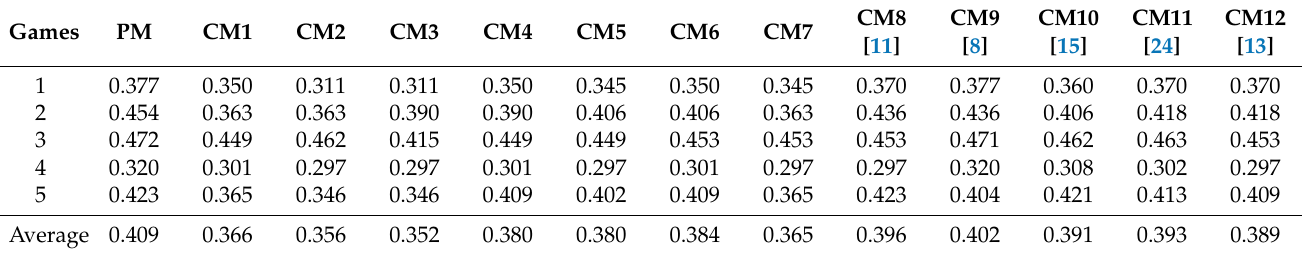
Table 3. Specificity of the detection of important scenes in the proposed method (PM) and